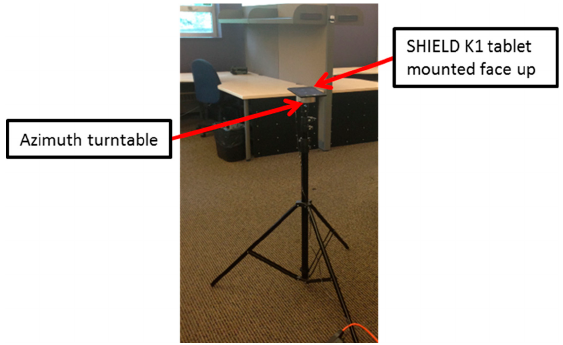
Figure 8. SHIELD K1 tablet mounted on tripod for RSS data collection.